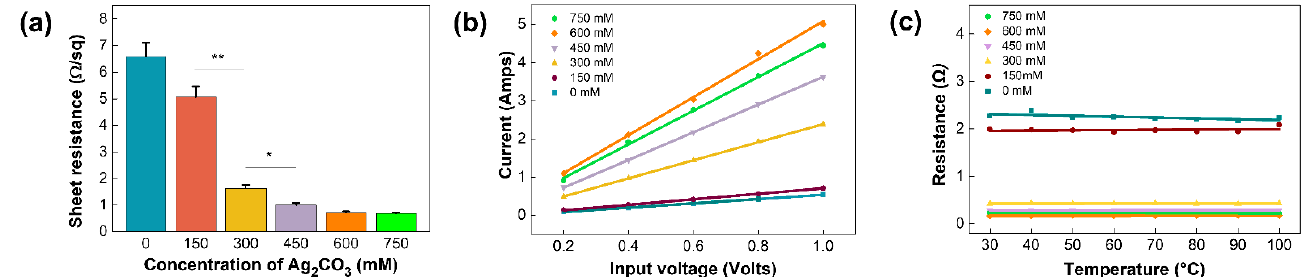
Figure 4. Electrical properties of the Ag/CF film: ( a ) sheet resistance of Ag/CF film with Ag 2 CO 3 concentrations (* p < 0.05, ** p < 0.01); ( b ) I–V characteristics of Ag/CF film with respect to Ag 2 CO 3 concentrations; ( c ) relationship between total resistance and temperature with various Ag 2 CO 3 concentrations.